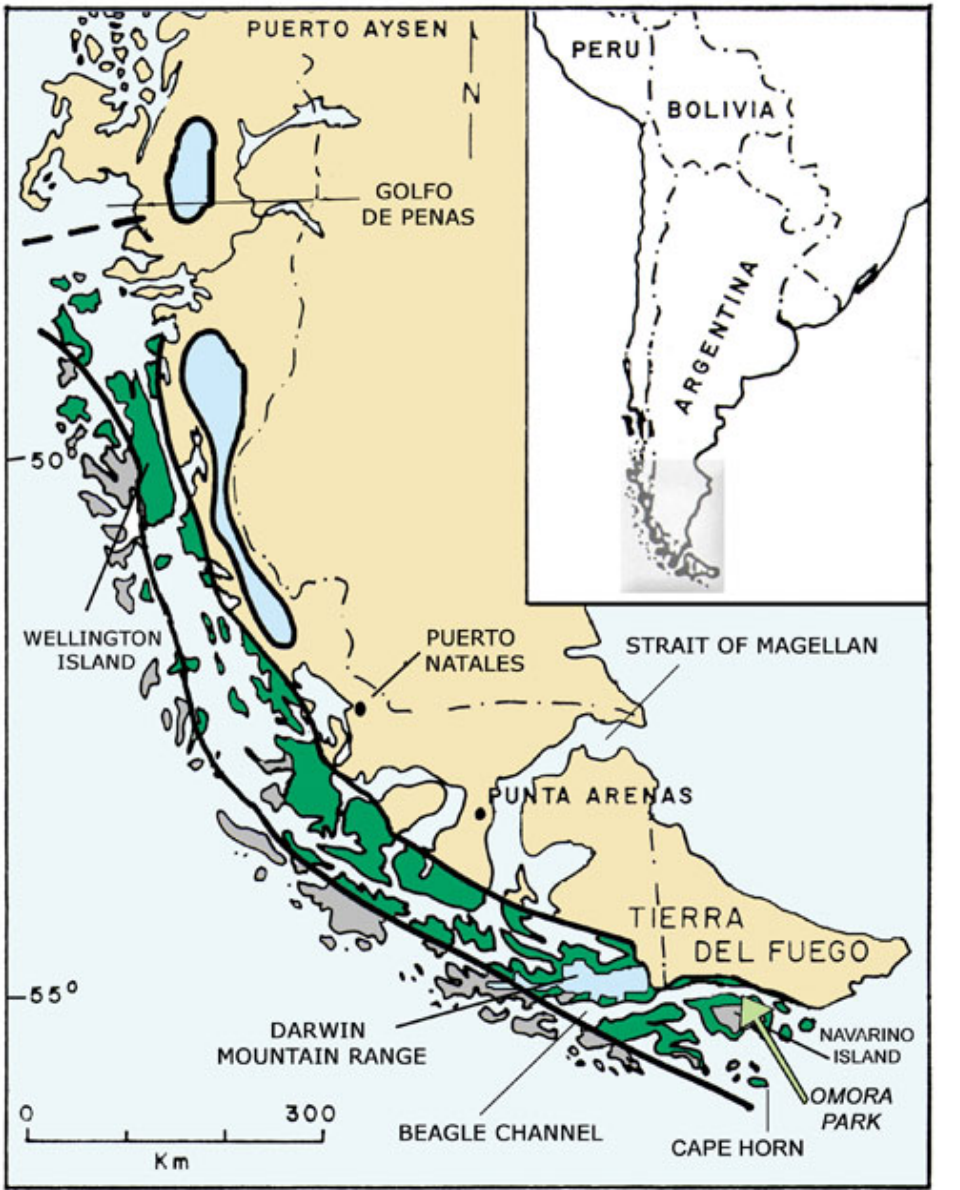
Fig. 1. Location of the Omora Park on Navarino Island south of Tierra del Fuego and the Beagle Channel, in the region of Cape Horn, at the southern extreme of the American Continent. Dark green depicts the subantarctic or subpolar Magallanic evergreen rainforest ecoregion, which runs along the Chilean Pacific Coast from Golfo de Penas (48º S) to Cape Horn (56º S). This ecoregion has been identified as one of the 37 most pristine areas in the world. The criteria to identify the most pristine ecoregions or wilderness areas in the world were: (1) 70% or more of their original vegetation intact, (2) cover at least 10,000 km 2 , and (3) have fewer than five people/km 2 (Mittermeier et al.